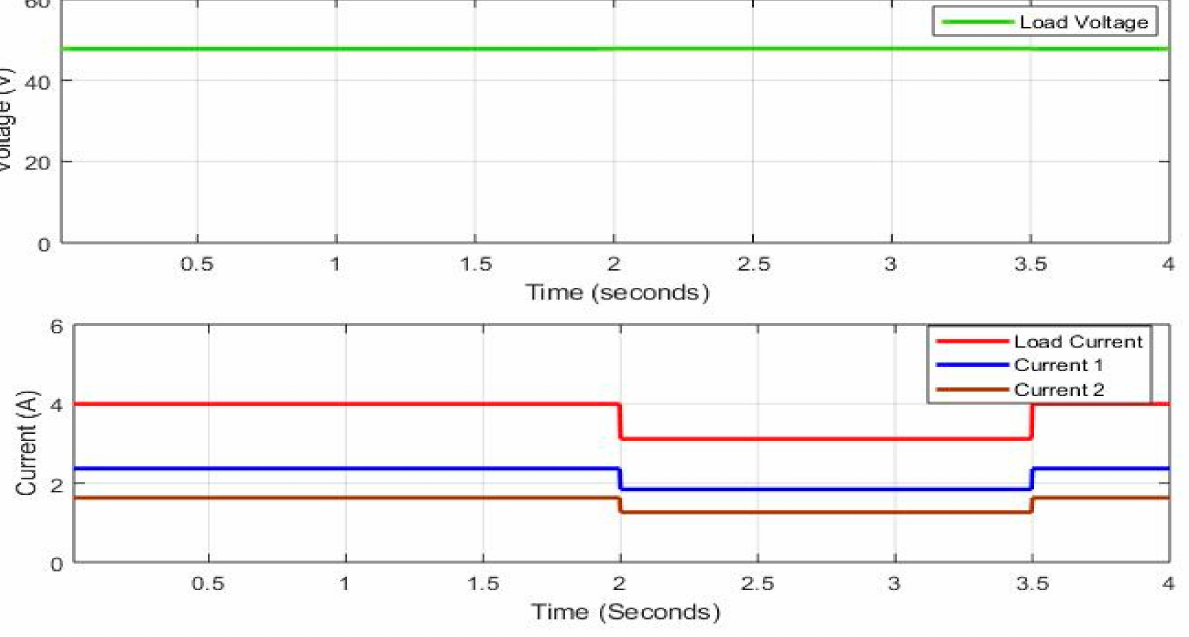
Figure 7. Simulation results for variation in load with different cable resistances without any droop control: load voltage, converter output currents and load